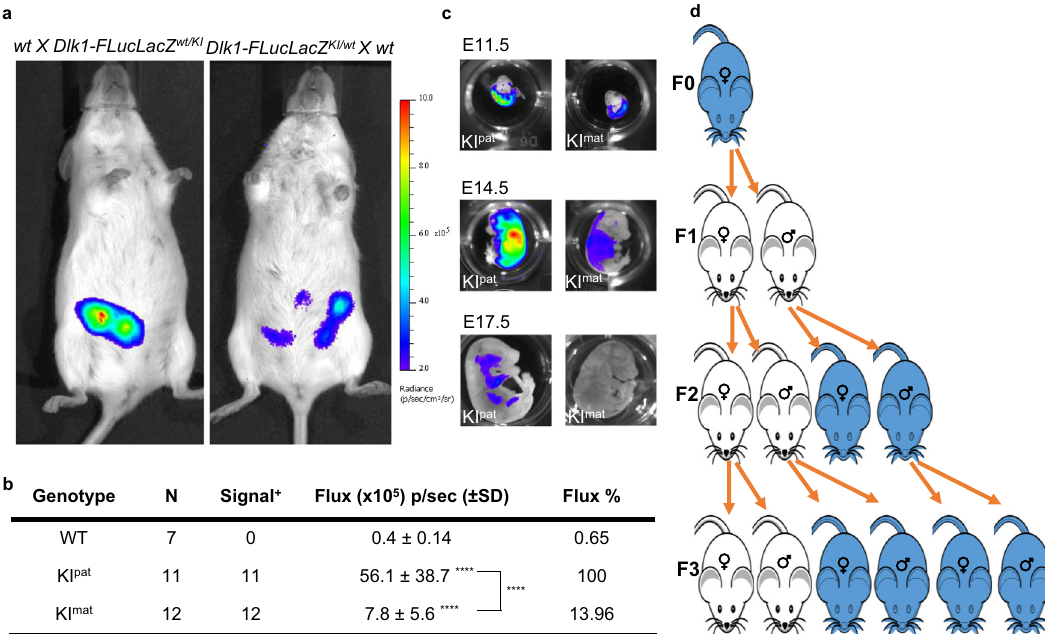
Fig. 2 Inheritance of imprinted Dlk1 reporter expression in embryos and across generations. a BL signal (blue) detected in Dlk1-FLucLacZ pregnancies arising from KI pat (left) and KI mat (right) transmission showed greater surface signal in KI pat pregnancies (E11.5). b Quanti fi cation of BL signal (Flux) detected in E11.5 Dlk1-FLucLacZ embryos following dissection, demonstrating higher levels of signal from KI pat than KI mat embryos. BL signal in wt and KI mat embryos is shown as a percentage of the average KI pat signal (number of embryos ( N ) indicated in table; One-way ANOVA on log-transformed data ( p < 0.0001); results of Holm- Š ídák ’ s multiple comparisons follow-up test are shown for comparisons to wt mice, and between KI pat /KI mat mice as indicated: ****adjusted p ( p adj) < 0.0001). Source data are provided as a Source Data fi le. c BL imaging of embryos at different stages (E11.5, E14.5 and E17.5) showed progressive reduction in signal (blue) in both KI pat (left panel) and KI mat (right panel) through gestation; signal was readily detected in E11.5 and E14.5 KI pat and KI mat embryos, but at later stages (E17.5) was only seen after paternal transmission. Signal intensity scales are equalised between images. d Transmission of mono-allelic imprinted Dlk1 reporter expression in four generations (F0, F1, F2, F3); upon paternal inheritance of Dlk1-FLucLacZ the reporter was expressed (blue), while maternal inheritance resulted in reporter silencing (white). Imprinting was predictably re-set across generations, through both germlines (a minimum of two independent litters were analysed per generation and reciprocal